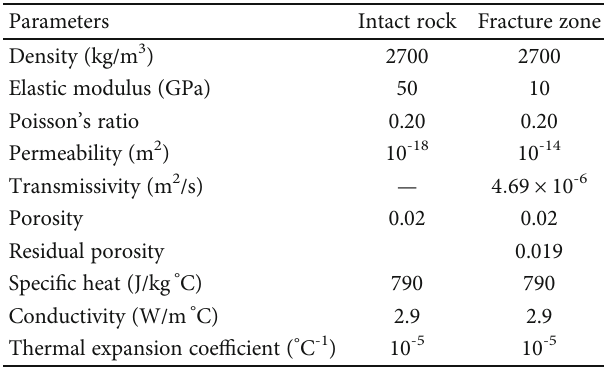
Table 1: Material properties used in the thermo-hydro-mechanical (THM) model. Note that the permeability is expressed in m 2 (1 × 10 -15 m 2 is equal to 1